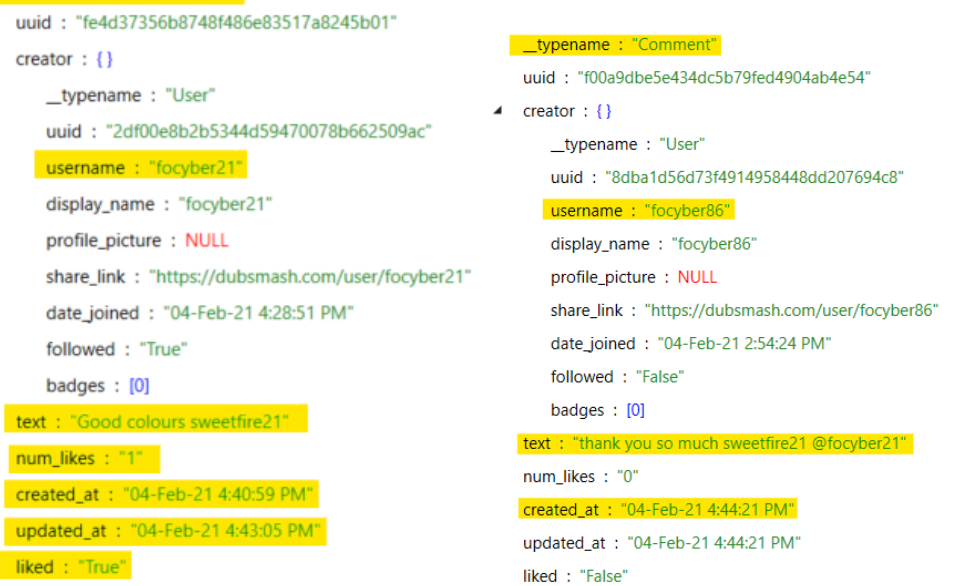
Figure 10. Comment left by iOS user ( left ) and Android user’s reply ( right ), as recovered from the Dubsmash app on Android.